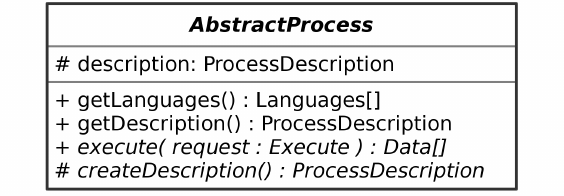
Figure 3. The AbstractProcess interface.